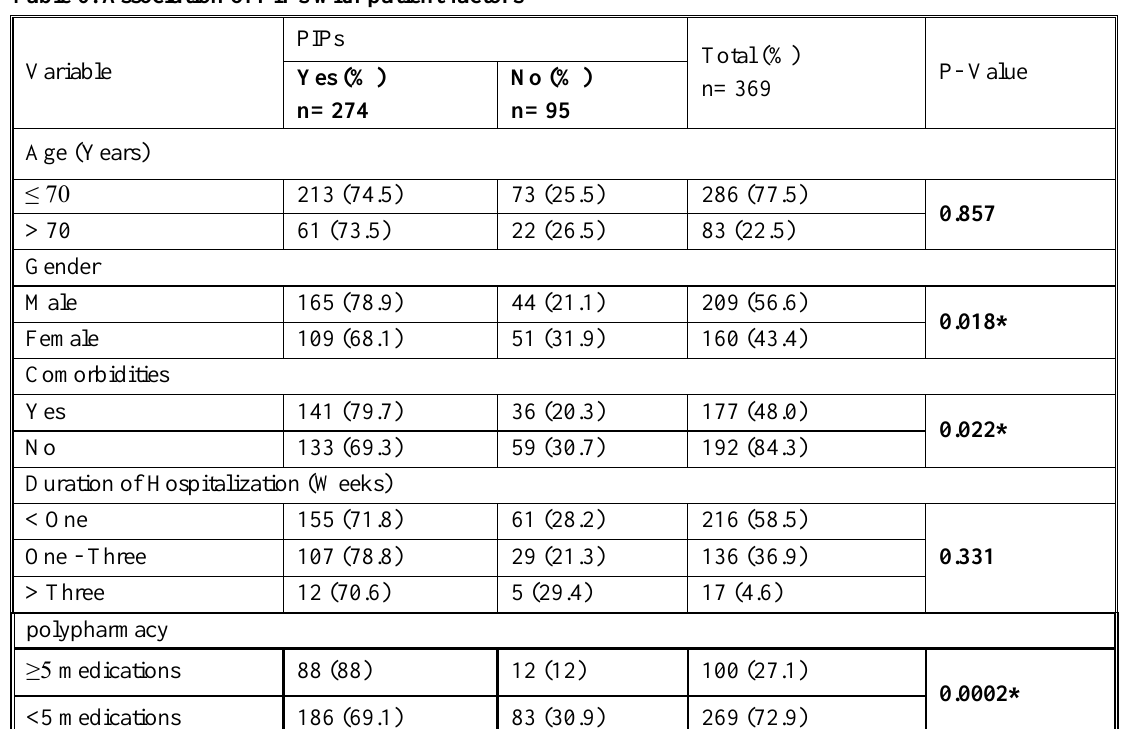
Table 6. Association of PIPs with patient factors